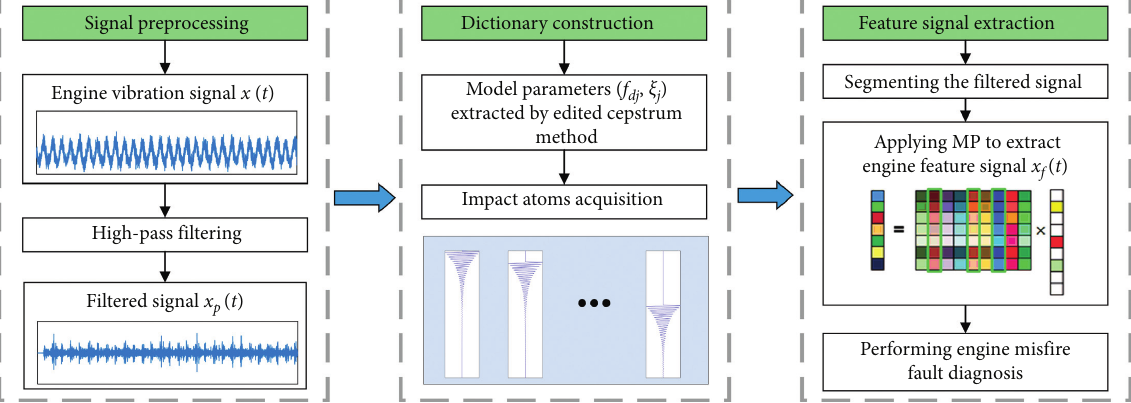
Figure 1: Flow chart of the engine signal feature